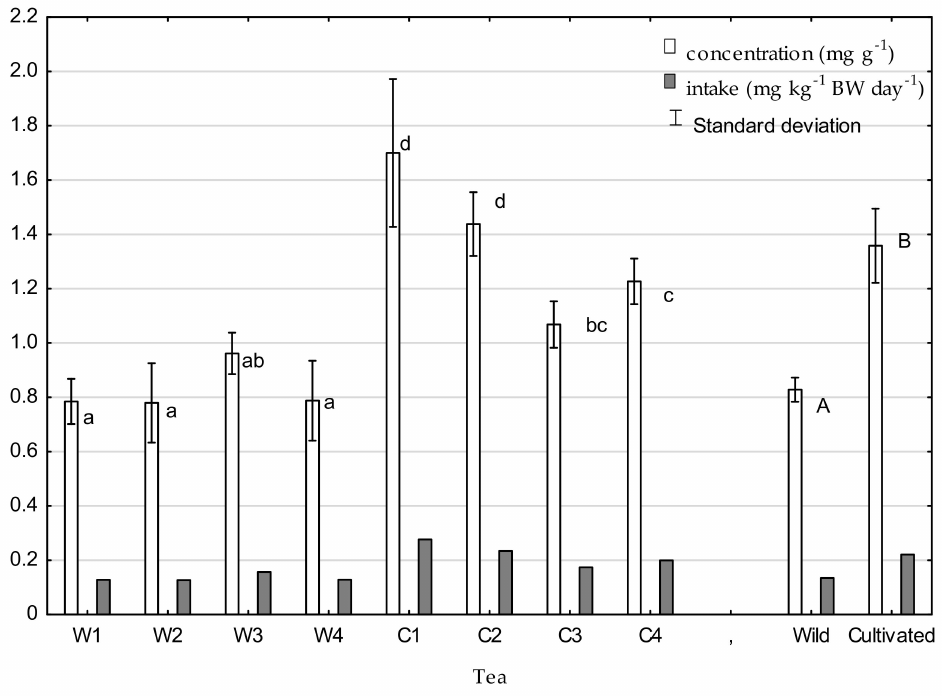
Figure 1. Nitrate concentrations in tea and daily intake with tea infusion. Means with different letters are significantly different, according to Tukey’s test ( p ≤ 0.05). W1wild tea, Wuzhishan; W2-wild